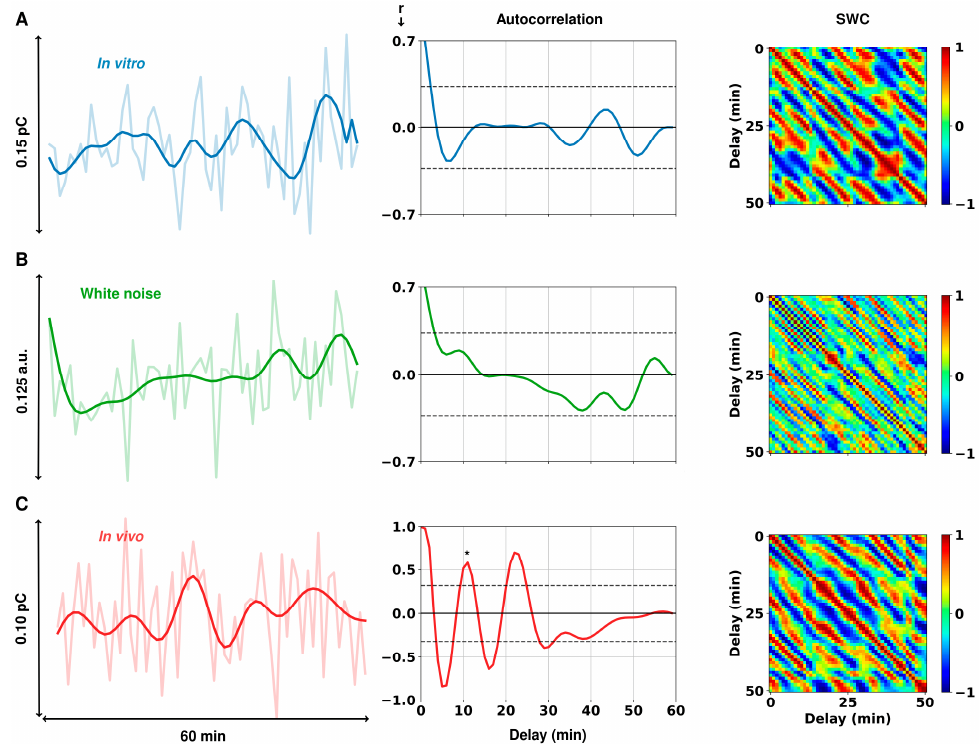
Figure 2. Representative FSCAV autocorrelation analysis. ( A ) In vitro FSCAV serotonin acquisition in 75 nM tris-buffered serotonin, shown in charge units (pC = picocoulombs); ( B ) random white noise with a standard deviation equal to the in vitro acquisition; and ( C ) in vivo FSCAV serotonin acquisition in the CA2 region of a mouse hippocampus, shown in charge units. The graphs on the left show both the unfiltered and filtered signals (3rd order Butterworth low-pass filter with 0.005 Hz cutoff frequency). The graphs in the center show the autocorrelation of each respective time series after filtering. Gray dashed lines show the limits of statistical significance. On the right are shown the SWC, as a function of the delay between 10-min windows of the respective time